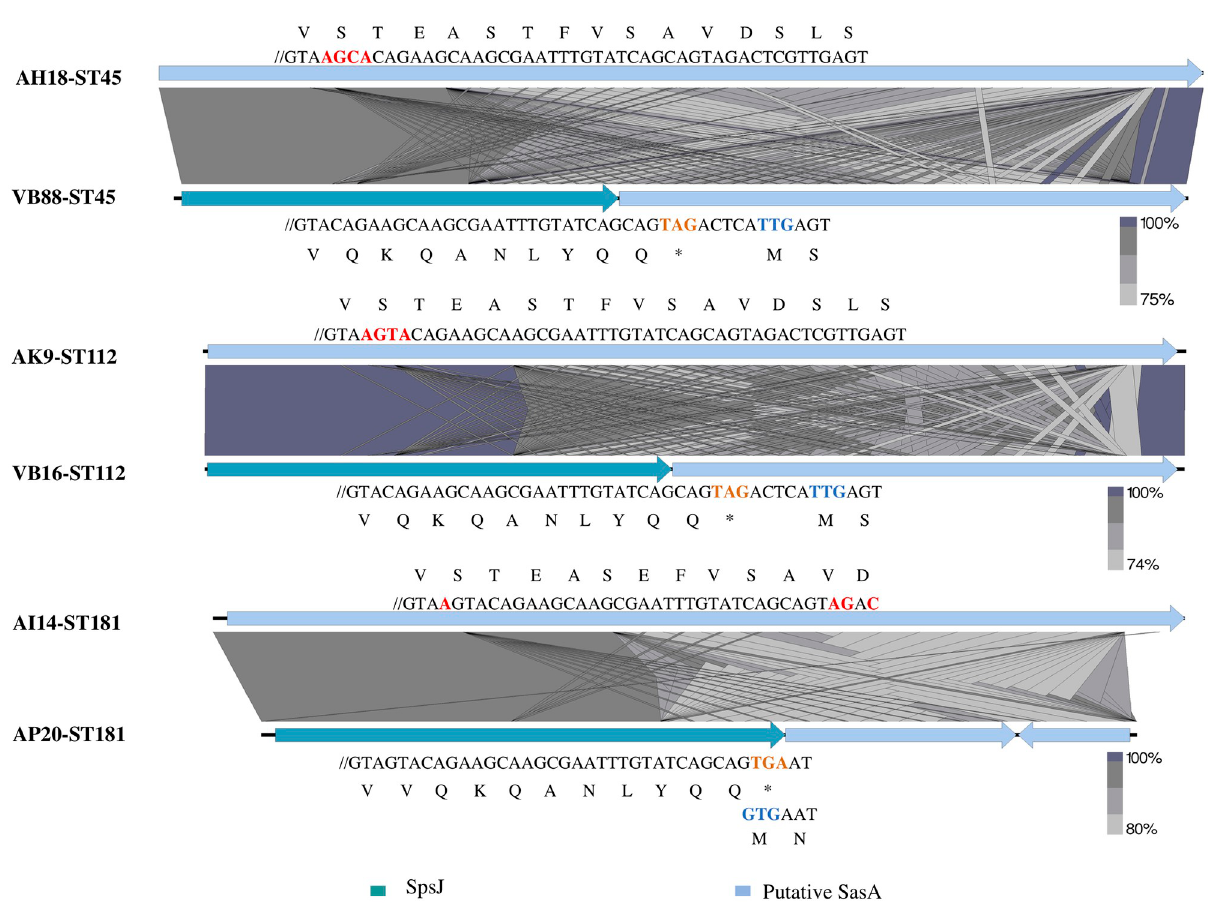
Fig 2. Illustration of CWA protein genes diversity found in human isolates. Comparison of spsJ and sasA gene in isolates from dogs and humans showing % nucleotide similarity, start codon (blue), premature stop codon (orange), and different nucleotide and amino acid sequence (red). Figure was generated using Easyfig